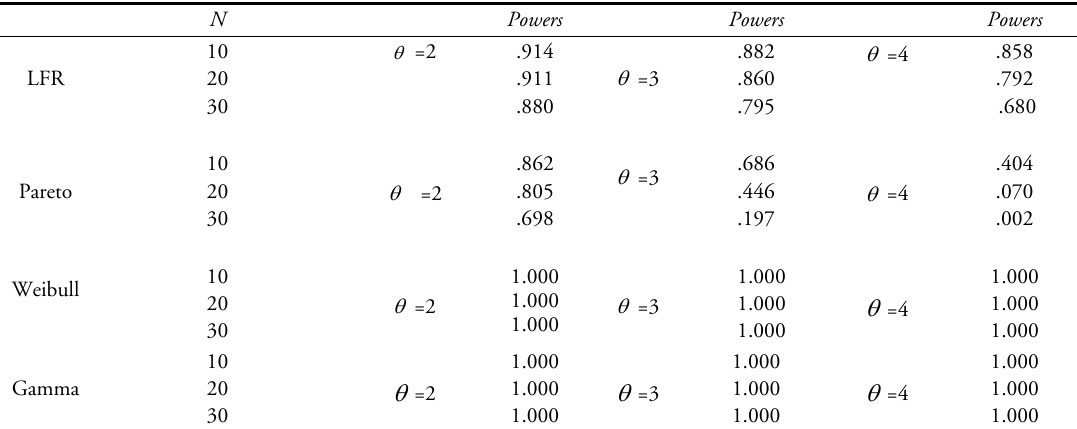
Powers for NBARFR class